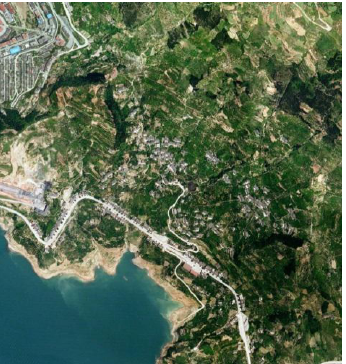
Fig.3 Ortho-photo of Zhangjiawan landslides